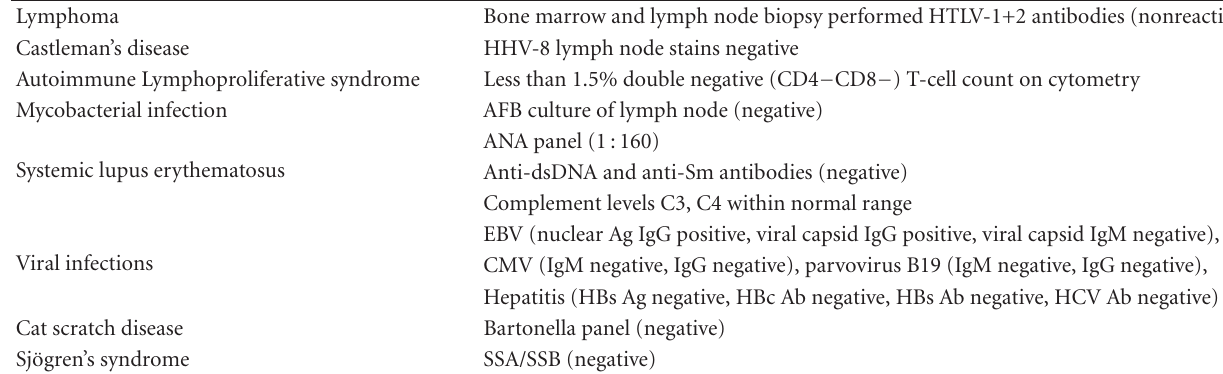
Table 1: Di ff erential diagnosis with pertinent laboratory findings ∗ .